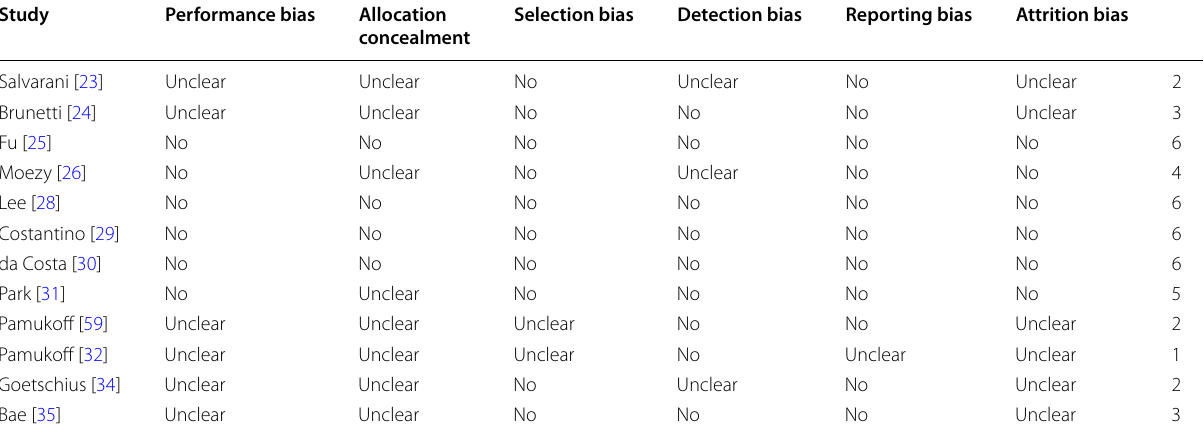
Table 3 Risk of bias assessment of included studies Study Performance bias Allocation Selection bias Detection bias Reporting concealment